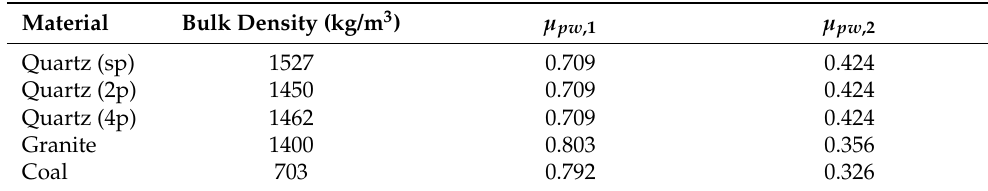
Table 3. Calibrated bulk density and friction coefficients between particles and walls. µ pw ,1 corre- sponds to the coefficient of friction between the wall of wood and the particle, and µ pw ,2 corresponds to the coefficient of friction between the wall of glass and the